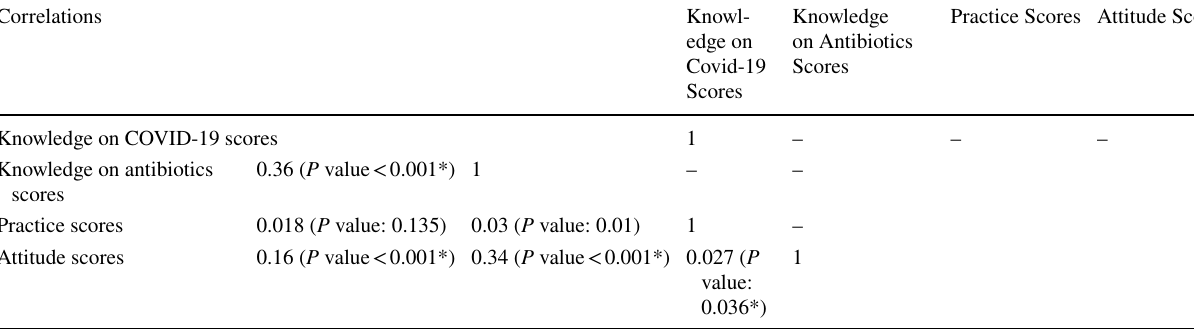
Table 9 the matrix correlation between the utilized assessment